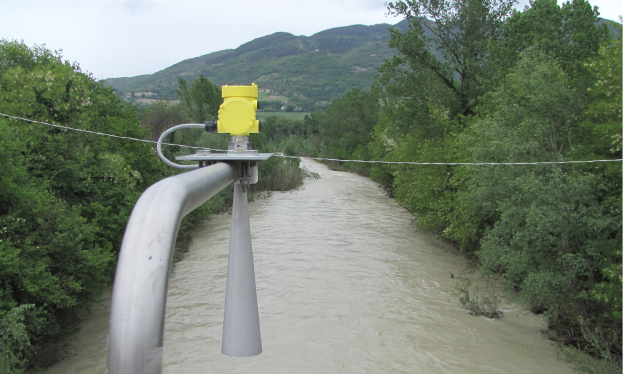
Figure 5. Example of gauge radar sensor used to acquire stage measurements (VEGAPULS SR 68, Table